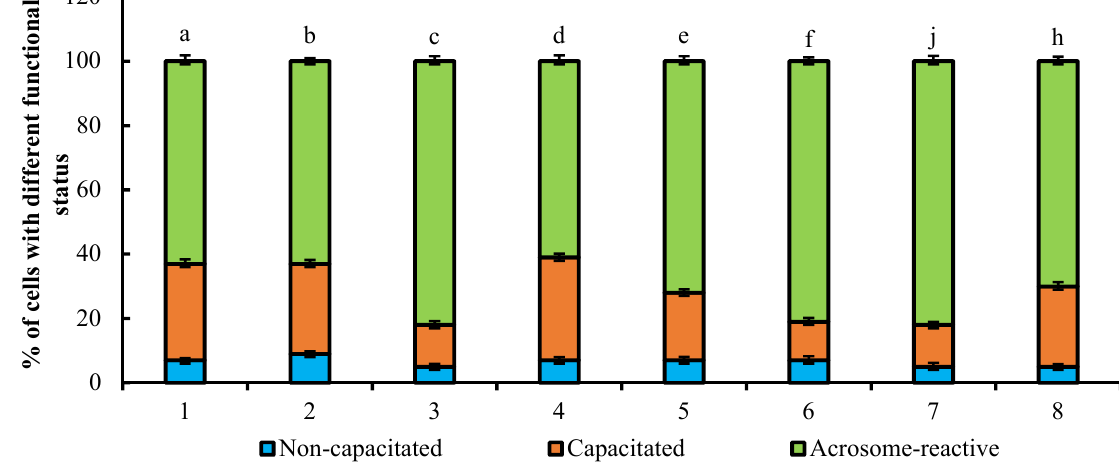
Figure 4. The effect of PRL (10 ng/mL) on appearance of bovine spermatozoa with different fluorescence patterns (total number of counted cells-6400; number of experiments–4). 1–without any reagents (control); 2–with 10 ng/mL PRL; 3–with 10 ng/mL PRL and 10 µM cytochalasin D; 4–with 10 ng/mL PRL and 10 µM nocodazole; 5–with 1 mg/mL PRG (control); 6–with 1 mg/mL PRG, 10 ng/mL PRL; 7–with 1 mg/mL PRG, 10 ng/mL PRL and 10 µM cytochalasin D; 8–with 1 mg/mL PRG, 10 ng/mL PRL and 10 µM nocodazole. The differences are significant (percent ratio of capacitated and acrosome-